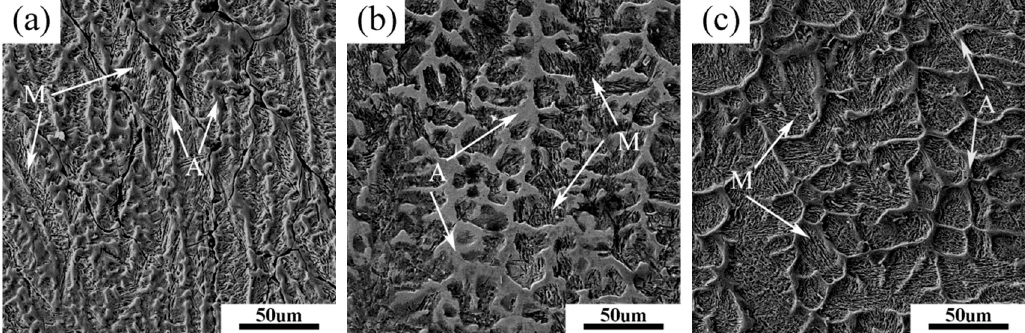
Figure 10. Microstructure of Weld bead at different heat inputs. ( a ) 4.2 kJ/cm, and ( b ) 5.4 kJ/cm, ( c ) 6.6 kJ/cm.